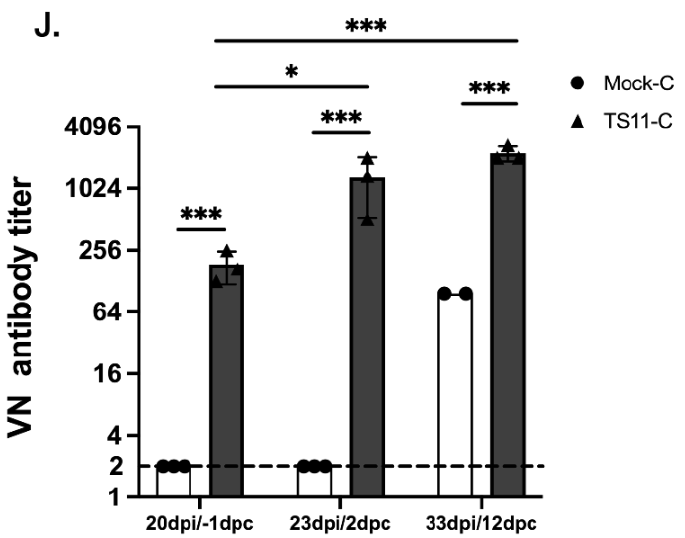
Figure 5. SARS-CoV-2 TS11 was attenuated in hamsters and conferred complete protection post challenge with a virulent heterologous D614G strain 14B. ( A ) Schematic procedure for the Syrian hamster study. Two groups of hamsters (n = 15 per group) were intranasally (i.n.) inoculated with 8 × 10 4 PFU/hamster of SARS-CoV-2 TS11 (for TS11-Challenge group) or culture medium (for Mock-challenge group). At 21 days post-inoculation (dpi), both groups of hamsters were challenged i.n. with a virulent heterologous D614G strain 14B (3 × 10 5 TCID 50 per hamster). ( B ) Body weights were measured daily from 1–4 dpi or days post challenge (dpc) followed by every 2–3 days. ( C ) Nasal washes were collected daily from 1–4 dpi/dpc followed by every 2–3 days and infectious viral titers were determined using Vero E6 cells. At 2 dpi, 6 dpi, 20 dpi, 23 dpi/2 dpc, and 33 dpi/12 dpc, 3 hamsters per group were euthanized. The infectious virus titers in the upper respiratory tract (URT) wash ( D ), nasal turbinates ( E ), Bronchoalveolar lavage fluid (BALF) ( F ), and lungs ( G ) were assessed by the TCID 50 assay. The dashed lines in C g indicate the detection limit. The histopathological changes of lungs were examined after hematoxylin and eosin staining (Arrows indicate lesions) ( H ) and immunohistochemical (IHC) staining of SARS-CoV-2 N proteins (brown color) ( I ). Black arrows indicated lesions or positive signals. Original magnification, × 60 (panels in H) or × 100 (panels in I). A typical area was also shown in an amplified box in the top right corner. Serum viral neutralizing (VN) antibody titers were tested using TCID 50 -reduction assay ( J ). The data were presented as mean ± standard deviation (SD). At each time point, values of the TS11 and WA1 groups were compared by Student’s t test (*, p < 0.05; **, p < 0.01; ***, p < 0.005). There was one outlier hamster [20] in the TS11-C group. It shed high titers of infectious virus in the lung homogenate (5.6 log 10 TCID 50 /mL) and the BALF sample (5.3 log 10 TCID 50 /mL) at 6 dpi. The hamster was gaining body weight from 1–3 dpi but lost 4% body weight from 4 dpi (141.9 g) to 6 dpi (136.3 g). Differentiation RT-PCR was performed